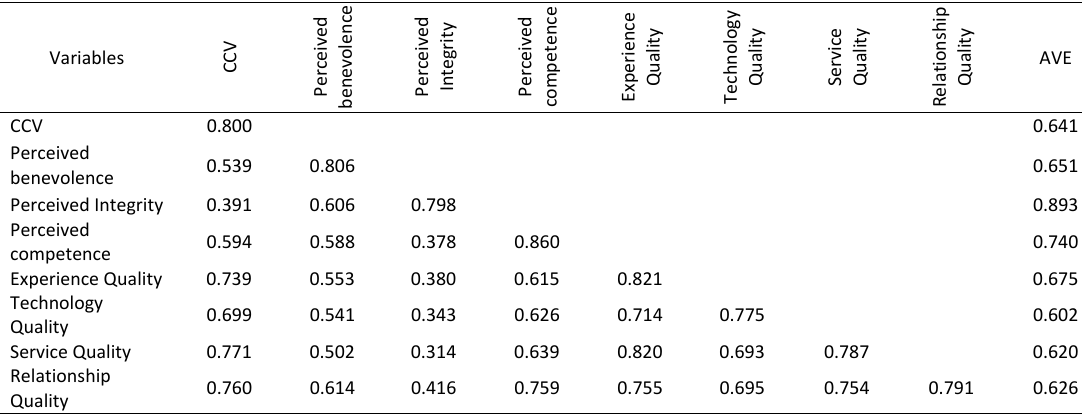
Table 2: Assessing the validity of model variables